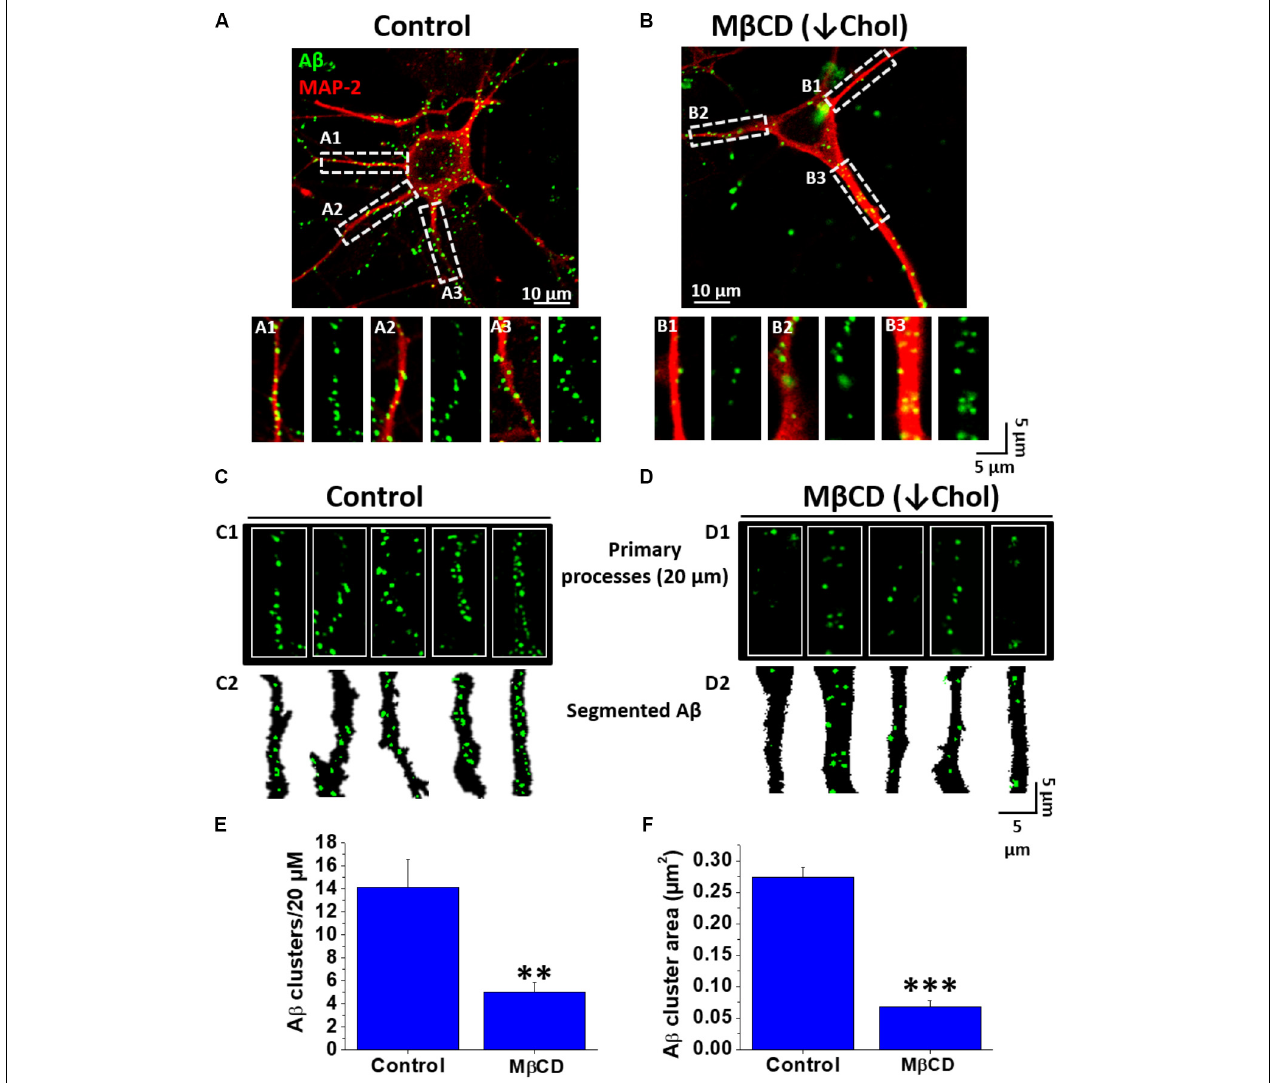
FIGURE 2 | Decreased A β association to neurons after lowering cholesterol. (A,B) Confocal microscopy images of hippocampal neurons exhibiting fluorescence for MAP-2 (red) and demonstrating the distribution of A β 42 -FAM (green) aggregates on the cell membrane in control and after treatment with M β CD (3 mM) for 30 min. (A1–A3,B1–B3) ROIs of representative neurites showing the overall distribution of A β (1 µ M, after 1 h treatment) on neuronal processes. (C,D) Representative traces of primary processes shown in (A,B) , respectively. (E,F) Quantification of A β clusters (number and area) in the first 20 µ m of hippocampal neuron primary processes showing that both parameters decreased after treatment with M β CD (3 mM) for 30 min. The bars represent the mean ± SEM. Asterisks denote: ∗∗ p < 0.005 and ∗∗∗ p <